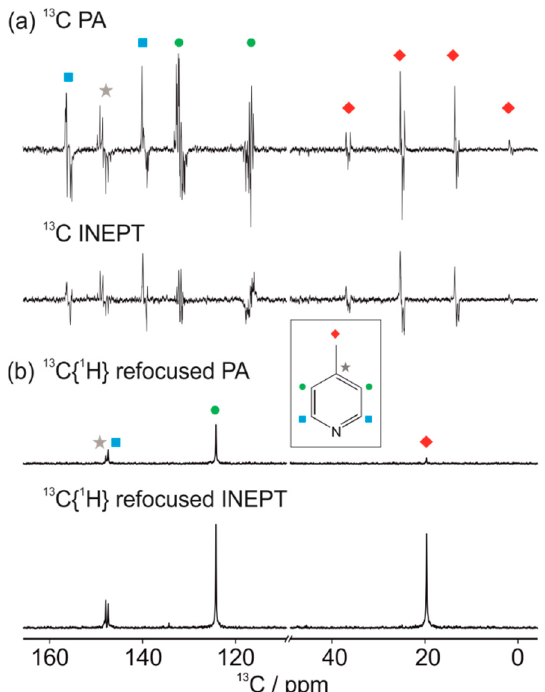
Figure 3. 1D SABRE-hyperpolarised 13 C NMR spectra of 260 mM 4-methylpyridine at natural abundance in MeOD with 5.2 mM active SABRE catalyst. Each spectrum was acquired in a single scan on a benchtop (43 MHz) NMR spectrometer following SABRE hyperpolarisation in a PTF of 6.1 mT. ( a ) Fully-coupled 13 C NMR spectra acquired immediately following a 90° 13 C pulse (top) and following INEPT transfer from 1 H with J CH = 10 Hz. ( b ) 13 C{ 1 H} NMR spectra acquired using PA (top) and INEPT transfer from 1 H (bottom). A refocusing delay of (3 J CH ) − 1 with J CH = 10 Hz was included prior to signal acquisition in both cases.